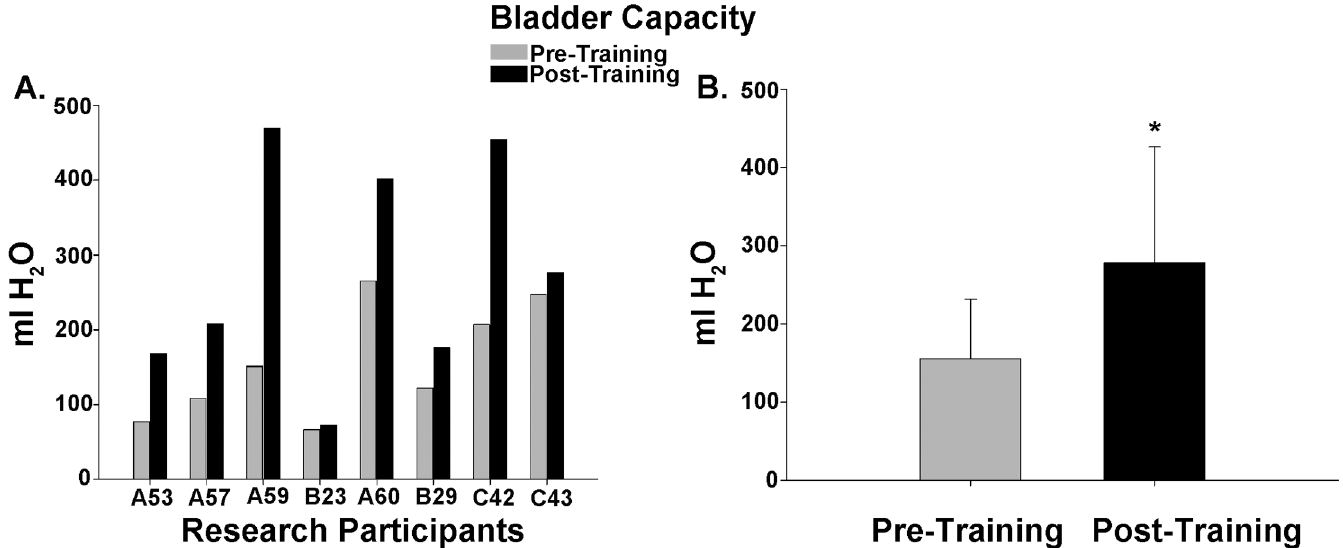
Fig 3. Bladder capacity data summary. Bladder filling ceased and capacity measured (leak + residual volumes) with the occurrence of either spontaneous urine leakage (n = 5; reflex void), autonomic dysreflexia (n = 2; Participants A60 and C42) or a voluntary void following a strong urge (AIS D Participant C43). (A) A comparison of pre- and post-training bladder capacity values in each of the eight participants. A binomial proportion test indicates that a significant majority of the research participants demonstrated an improvement in bladder capacity (vs. random occurrence, p < .05). Note that research participant B23 had a suprapubic catheter and thus, the increase in capacity was incremental. (B) Bladder capacity increased significantly post-training (p = .02, 155.4 ± 76.1 vs 278.5 ± 147.8 ml).